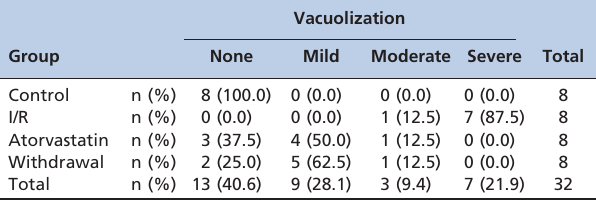
Table 4 - The extent of vacuolization of the spinal cord tissue for each group.